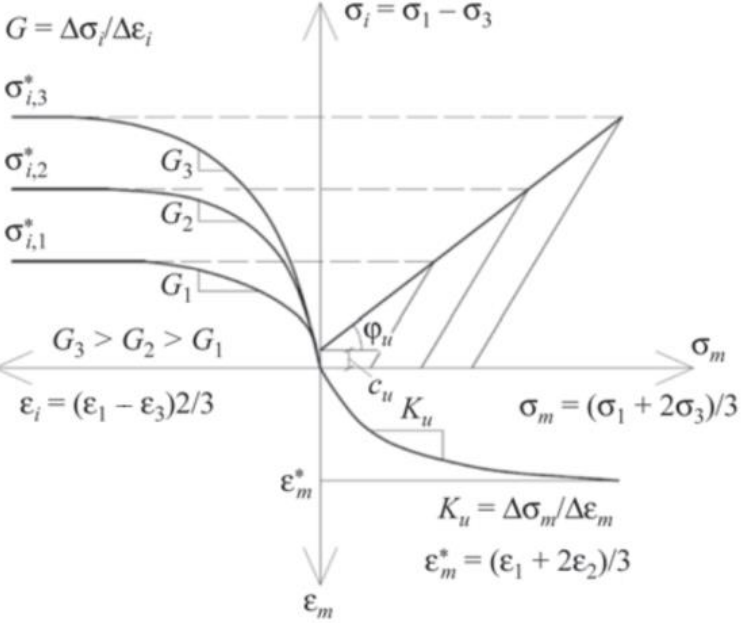
Figure 1. Schematic representation of the results of standard triaxial soil tests under a kinematic loading mode or along the path of crush.